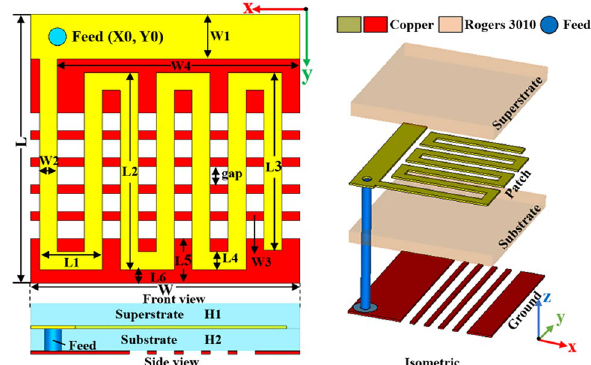
Figure 2. Implantable antenna structure diagram (Unit: mm).